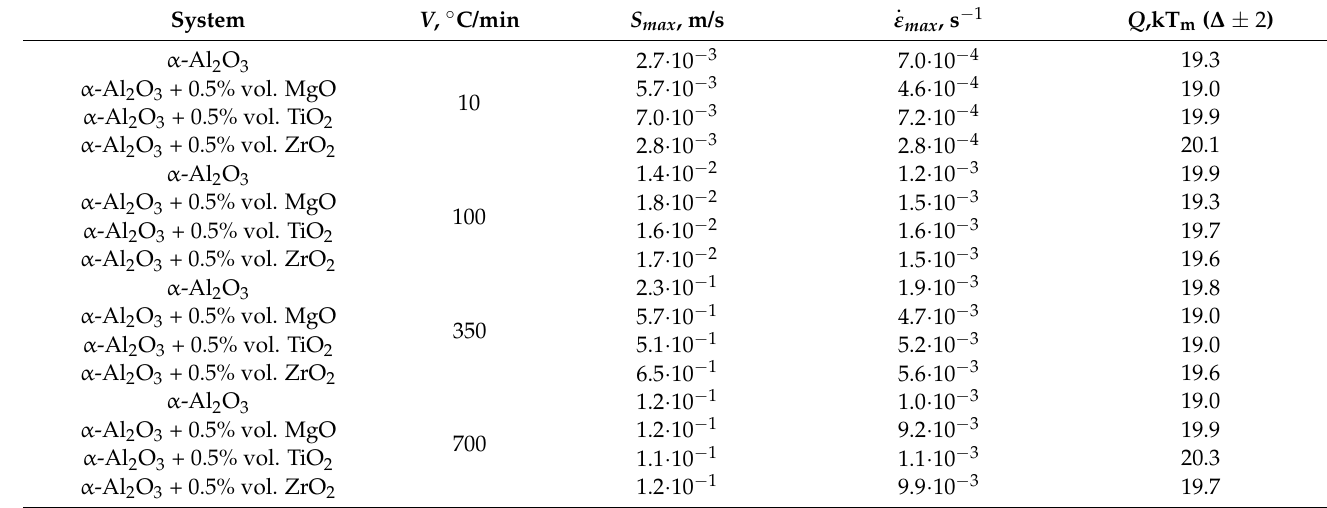
Table 4. Calculation of the activation energy of grain boundary sliding on the second stage of